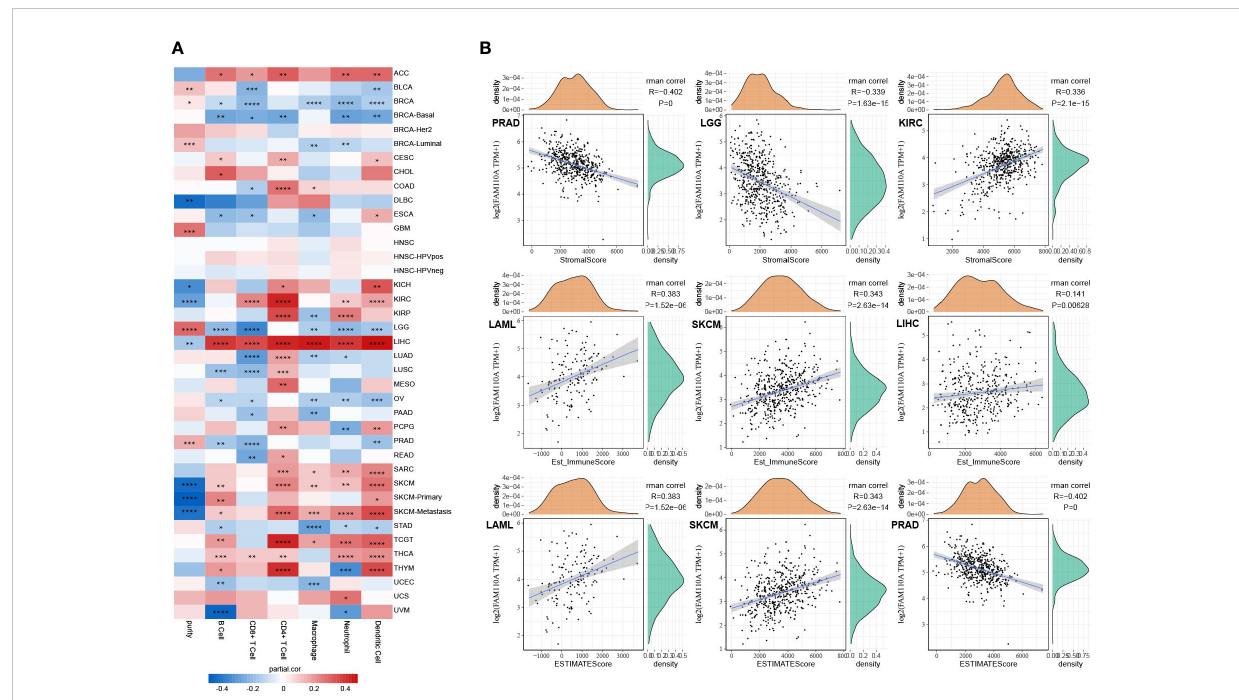
FIGURE 6 Correlation of FAM110A expression with immune in fi ltration. (A) Connection between FAM110A expression and the degree of immune cell in fi ltration in multiple malignancies using the in fi ltration scores of six immune cell types (B cell, CD4+ T cell, CD8+ T cell, neutrophil, macrophage, and dendritic cell) accessible in the TIMER database. (*P<0.05, **P<0.01, ***P<0.001, ****P<0.0001) (B) The top three tumors with the most signi fi cant correlation of FAM110A expression with stroma score, immune score and estimate score.